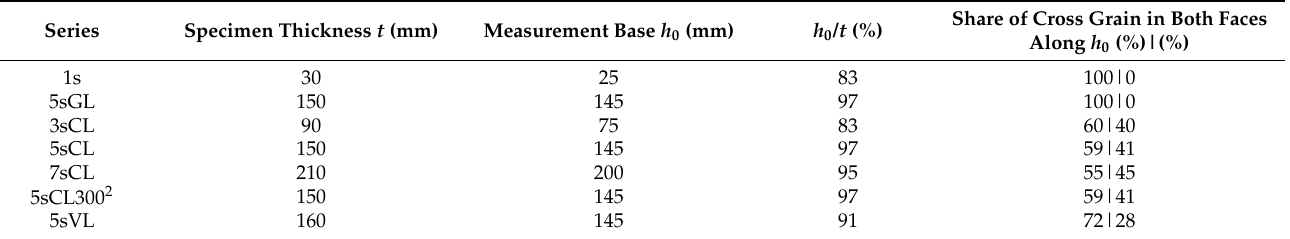
Table 3. Absolute and relative measurement bases as well as shares of cross grain in both faces of tested